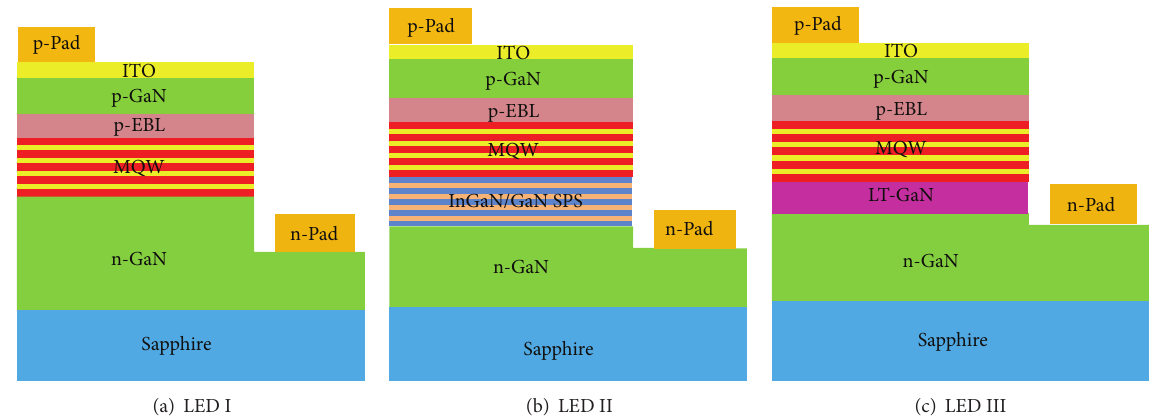
Figure 1: The schematic structures of the three fabricated LEDs. (a) LED I without any specific prestrain interlayer. (b) LED II with InGaN/GaN SPS interlayer. (c) LED III with LT-GaN interlayer.